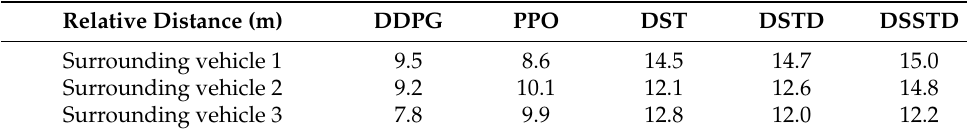
Table 5. Minimum relative distance to the leading vehicle.